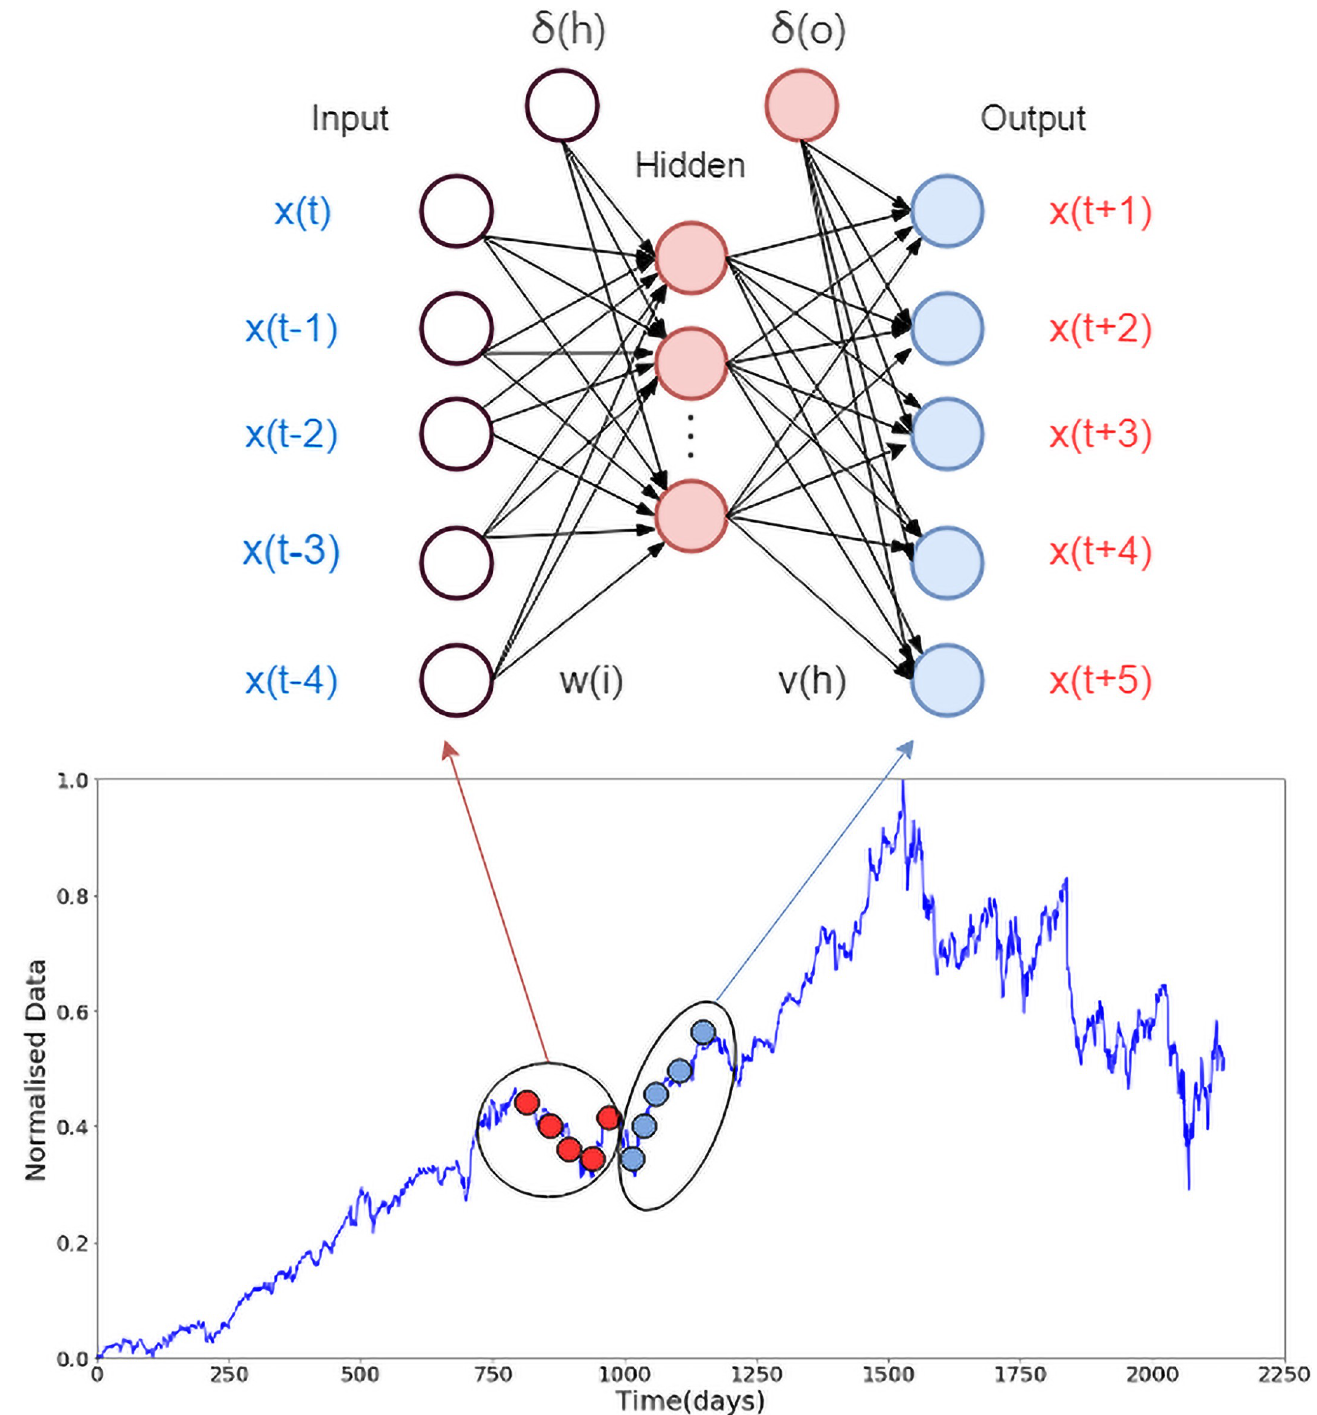
Fig 1. The time series (shown in red circles) is used as input for the neural network which predicts 5 steps-ahead in time (shown by black circles). A sliding window approach is used to reconstruct the dataset in this way using Taken’s theorem.